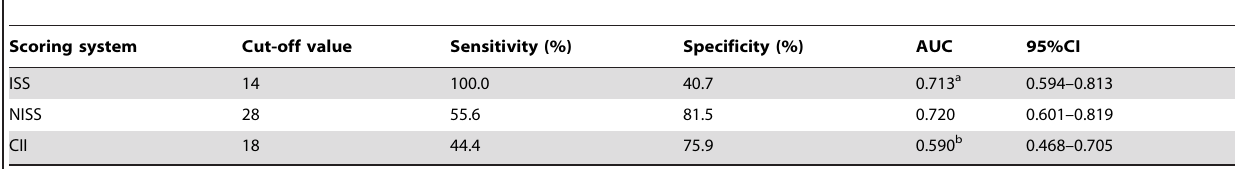
Table 6. Comparison of the ability of conventional injury severity scores to predict respiratory failure in patients admitted to our hospital from the Lushan earthquake.